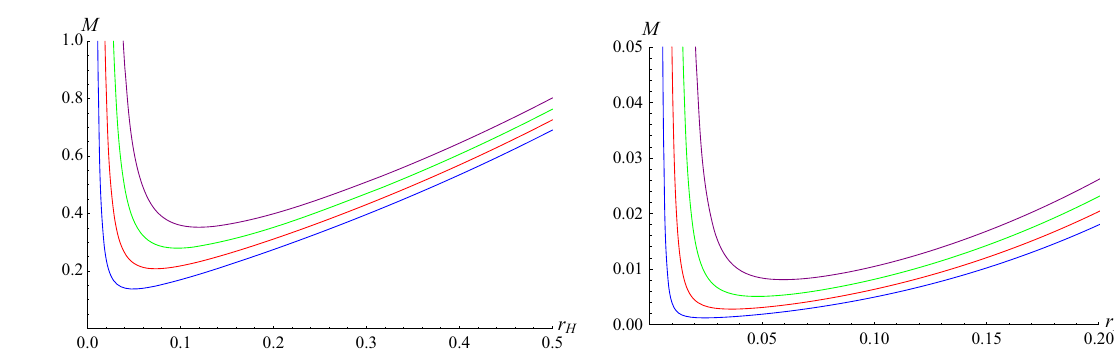
red, green and purple curves correspond to k = 0 . 1 , 0 . 15 , 0 . 2 , 0 . 25, respectively. Left panel: c 2 = 1. Right panel: c 2 = −